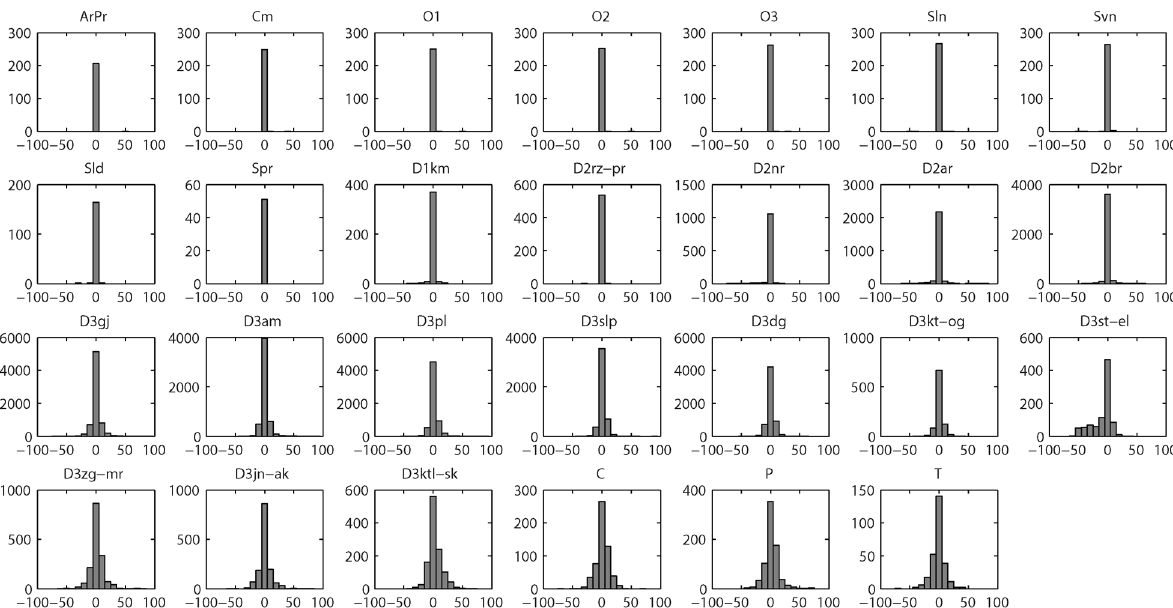
Fig. 10. Frequency distribution of the offset between borehole data and the model layers. x -axes – offset values (m), y -axes – point